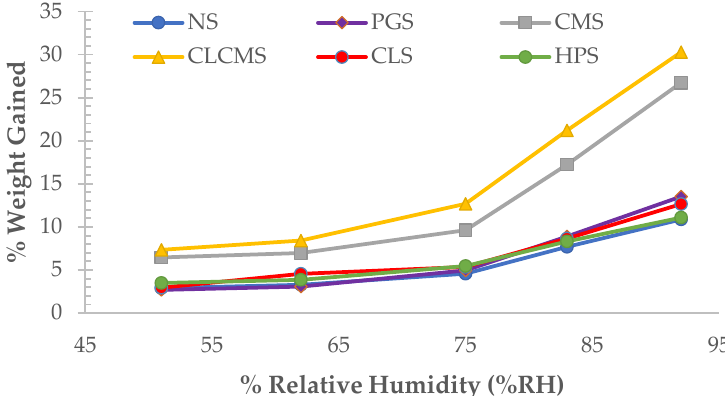
Figure 6. Moisture Sorption Profiles of Native (NS) and Five Modified KJ CMU-107 Rice Starches, Including Pre-gelatinized Starch (PGS), Carboxymethyl Starch (CMS), Crosslinked Carboxymethyl Starch (CLCMS), Crosslinked Starch (CLS), and Hydroxypropyl Starch (HPS).